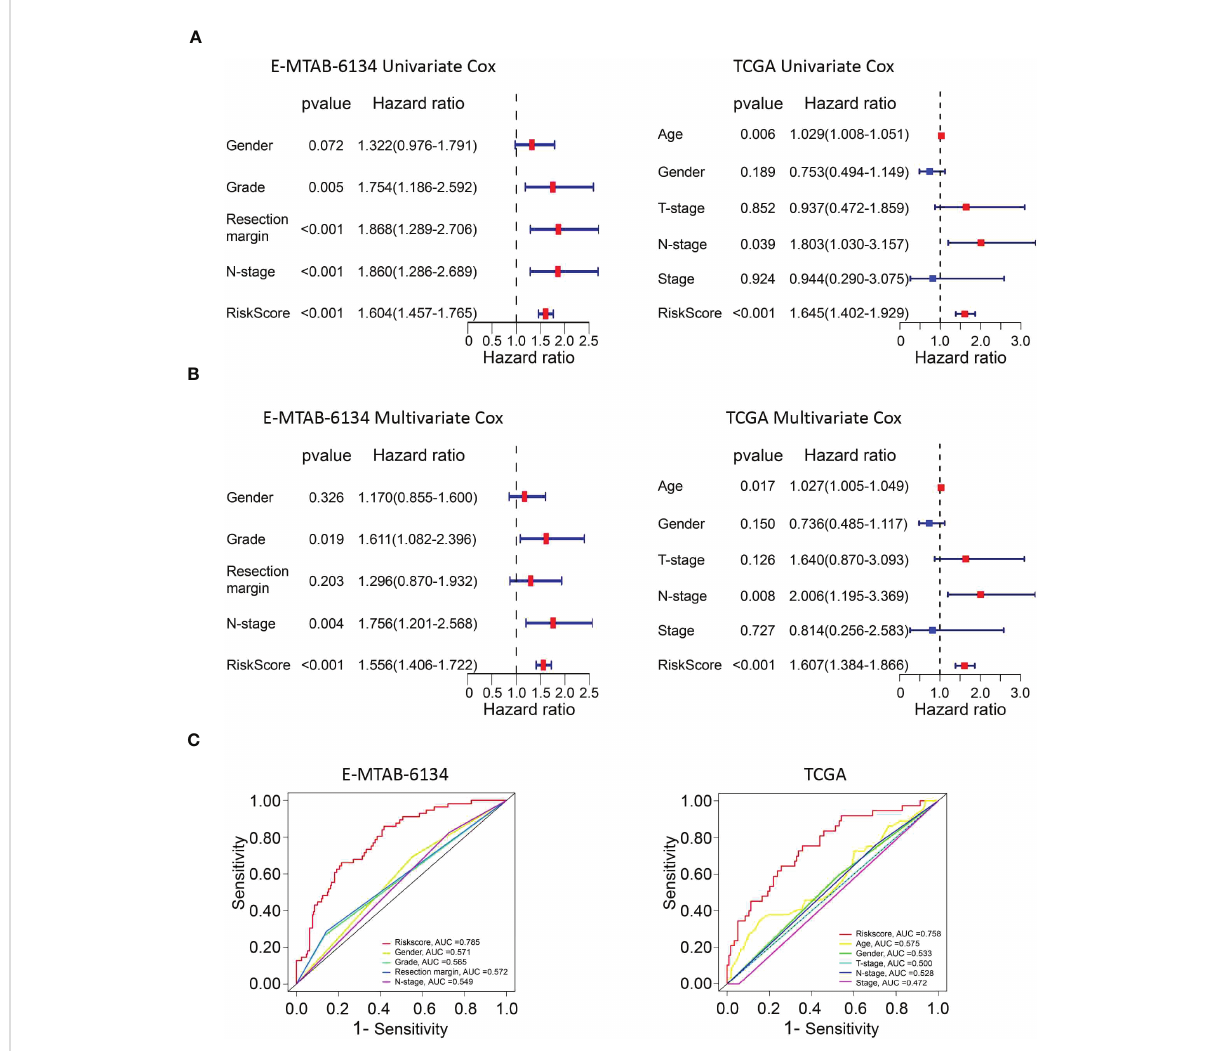
FIGURE 5 The predictive performance of the risk score and other clinicopathological parameters. (A, B) Validation of the risk score as an independent prognostic factor using univariate Cox analysis and multivariate Cox analysis in E-MTAB-6134 cohort and TCGA cohort. (C) ROC curves indicate the difference in AUC between clinical pathological